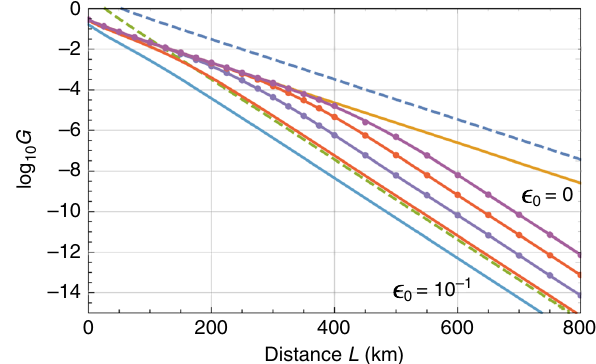
Fig. 6 Performance of our protocol. We assume photon-number-resolving detectors with quantum ef fi ciency 1 (cid:2) ϵ 0 . We assume L att = 22 km. Solid curves represent the asymptotic fi nal secret key rate G (per pulse) for ϵ 0 = 0, 10 − 5 , 10 − 4 , 10, − 3 , 10 − 2 , 10 − 1 from the above in order, while the upper and lower dashed curves represent the private capacities of the optical network 14 – 16 of Alice, Bob and the middle node C and of point-to-point communication 12 between Alice and Bob, respectively. Solid curves with dots are obtained by fi tting a smaller number of dots, compared with other curves. From this fi gure, we can con fi rm that our protocol has a scaling of η ϵ ¼ 0, with no scaling gap with the private L /2 in the ideal case of 0 capacity. We also see that our protocol is quite sensitive to local loss and requires very high detection ef fi ciency. However, as explained in the main text, our protocol could be further improved via loss-tolerant encoding